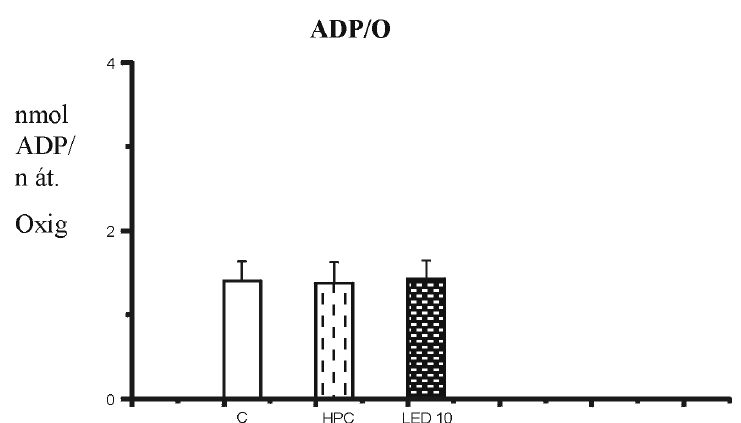
Figure 2 - ADP/O index in the groups Control (C ), Partial Hepatectomy- control (HPC ) and HPC and